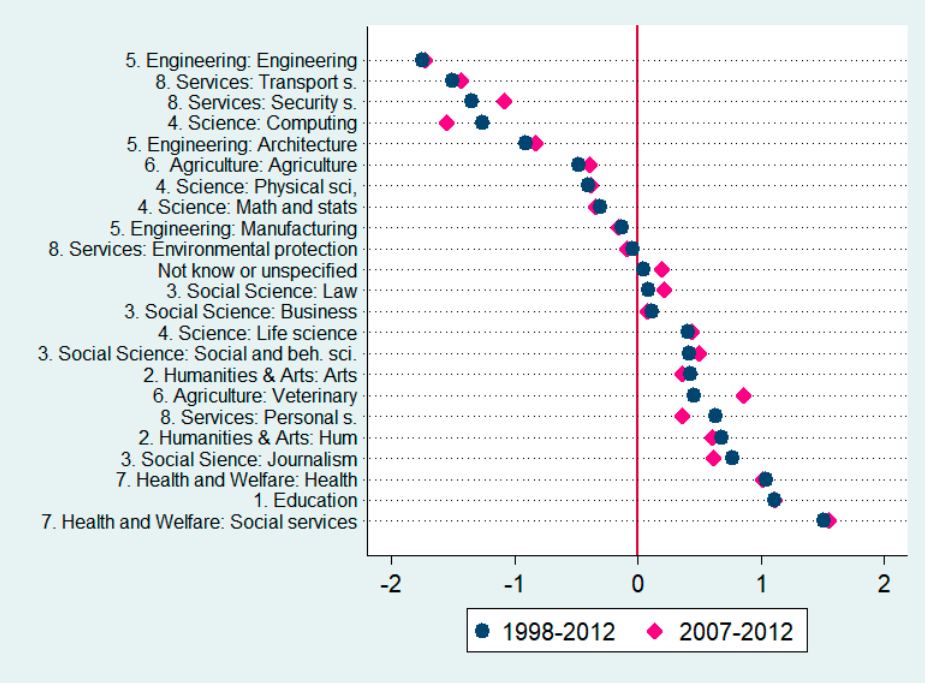
Figure 3. Subfield Segregation—Association Index.